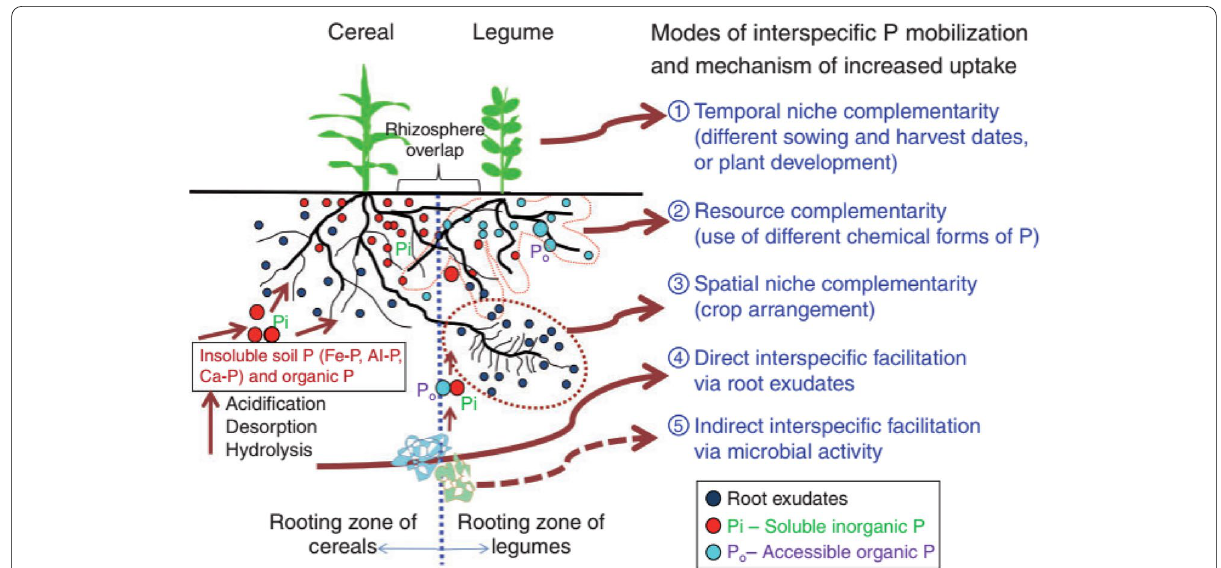
Fig. 3 Direct and indirect modes of increased phosphorus (P) uptake in cereal/legume intercropping (adapted from (Xue et al.